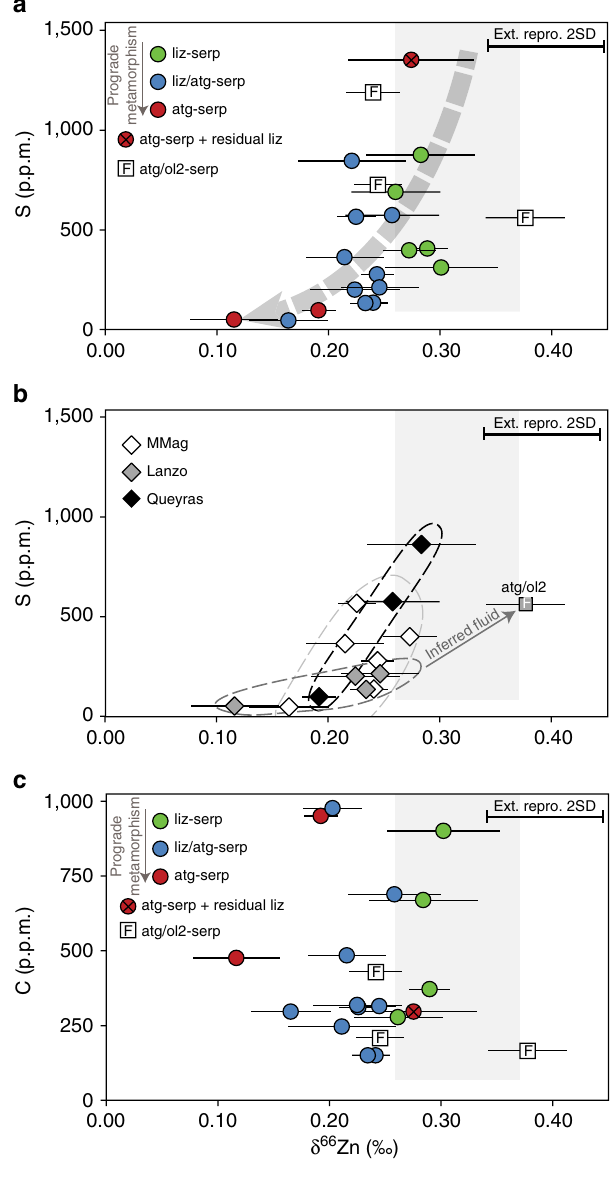
Figure 3 | Zinc isotope compositions versus sulfur and carbon contents in serpentinite samples from various Western Alps ophiolites. ( a ) Evolution of bulk d 66 Zn and S content in Western Alps serpentinites samples with regard to their main mineralogy and metamorphic grade. ( b ) Evolution of bulk d 66 Zn and S content in Western Alps serpentinites samples with regard to their geographical location. The depletion in heavy Zn isotopes is associated with the loss of S from the slab during prograde metamorphism and serpentinite devolatilization (schematic grey dotted arrow; a). Secondary olivine-bearing serpentinites (white squares) display both heavy Zn values and high S concentrations. This evolution reflects the progressive release of S with metamorphism and the concomitant preferential leaching of heavy Zn isotopes and provides strong evidence in favour of the release of SO 4 2 (cid:2) -rich, high- d 66 Zn oxidizing fluids during serpentinite devolatilization in subduction. At the outcrop scale, this trend is even stronger (b, grey to black dashed envelopes). ( c ) Evolution of d 66 Zn and C content in Western Alps serpentinites samples with regard to their main mineralogy. No correlation between d 66 Zn and C content is observed. MMag: Monte Maggiore. liz, atg: lizardite, antigorite-serpentinites. atg/ol2: secondary olivine-bearing serpentinites. Grey fields: expected range of possible S (C) contents and d 66 Zn compositions of greenschist facies serpentinites, according to the literature 27,33 . Sample error bars represent the 2 s.d. reproducibility of replicate analyses and a bold error bar is also shown on all plots indicating the external reproducibility (2 s.d.) of rock standards, from dissolution through to mass spectrometry